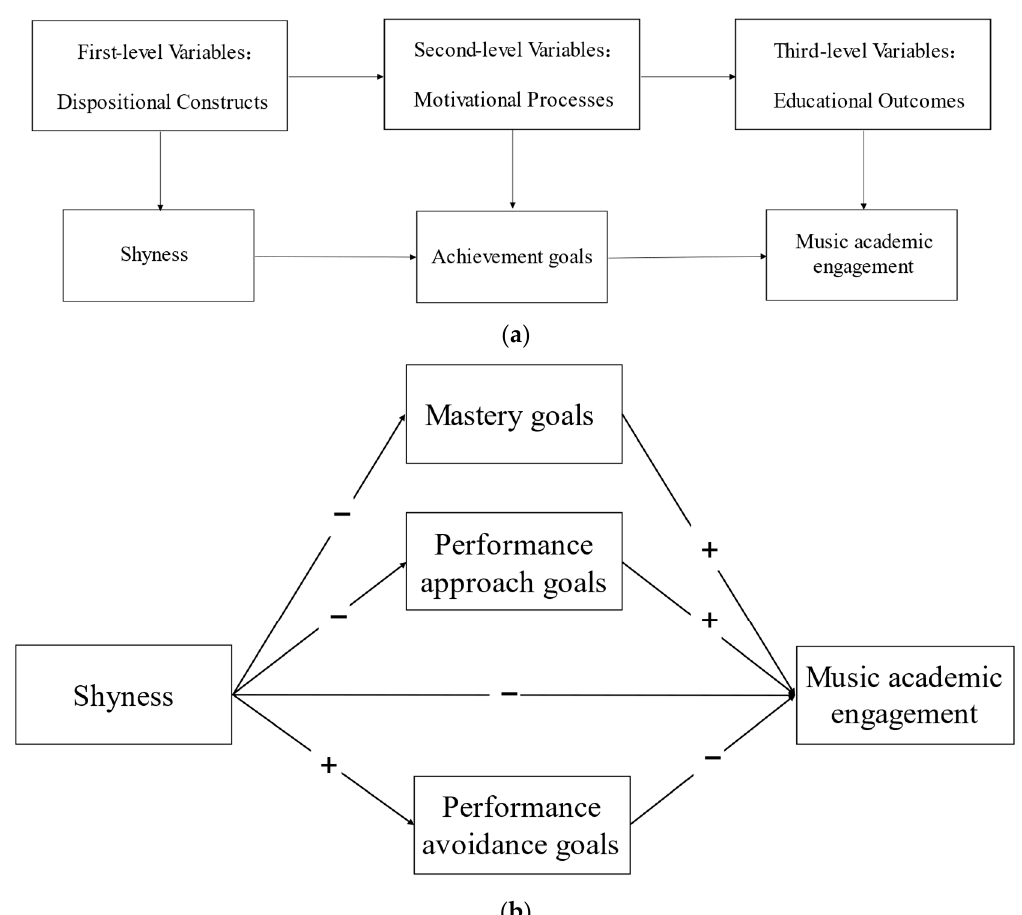
Figure 1. ( a ) The Models of Personality and Affect and hypothesis of the relation among achieve- ment goals, shyness and music academic engagement. ( b ) Hypothesis model of the relation among achievement goals, shyness and music academic